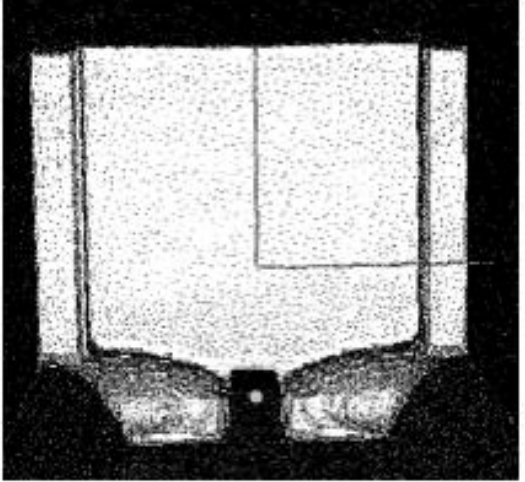
Figure 62. FLOW-3D CFD model of front view of the discontinued internal pipeline located ~ 2 m back from the wall opening.